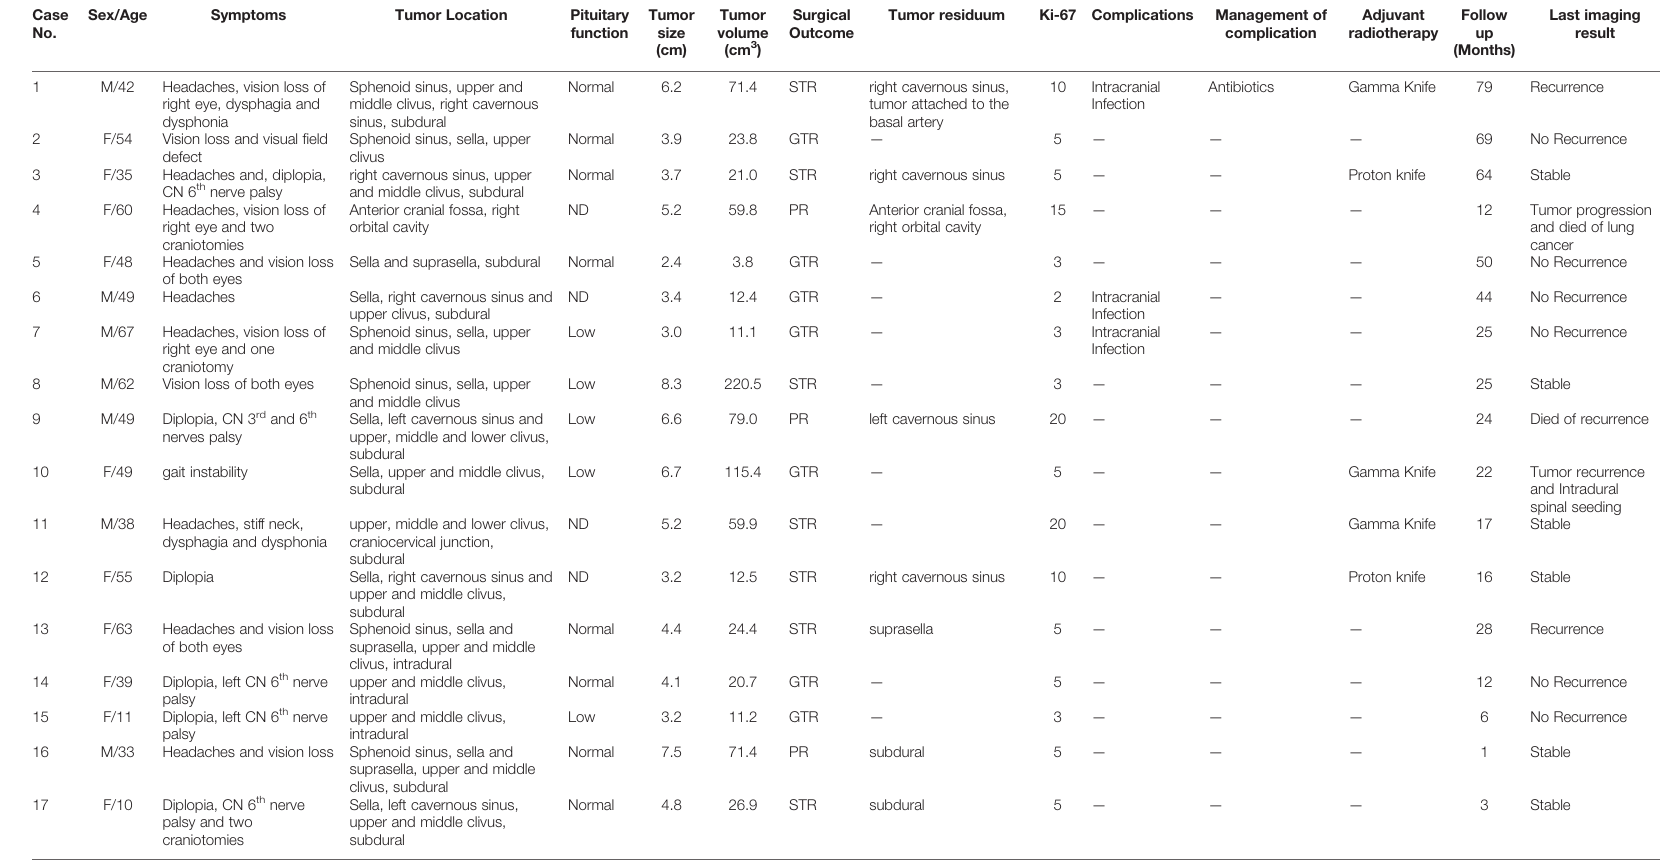
TABLE 1 | Clinical characteristics and surgical outcomes of the 17 patients with clival chordoma. Case